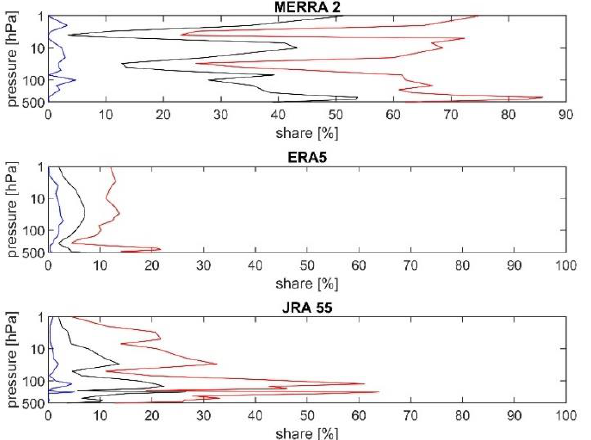
Figure 7. Vertical profile of average (black), minimal (blue) and maximal (red) share of explained discontinuities by the change in 2004 and 2015 to all grids from all months from the Pettitt test for MERRA-2 ( upper panel ), ERA-5 ( middle panel ) and JRA-55 ( lower panel